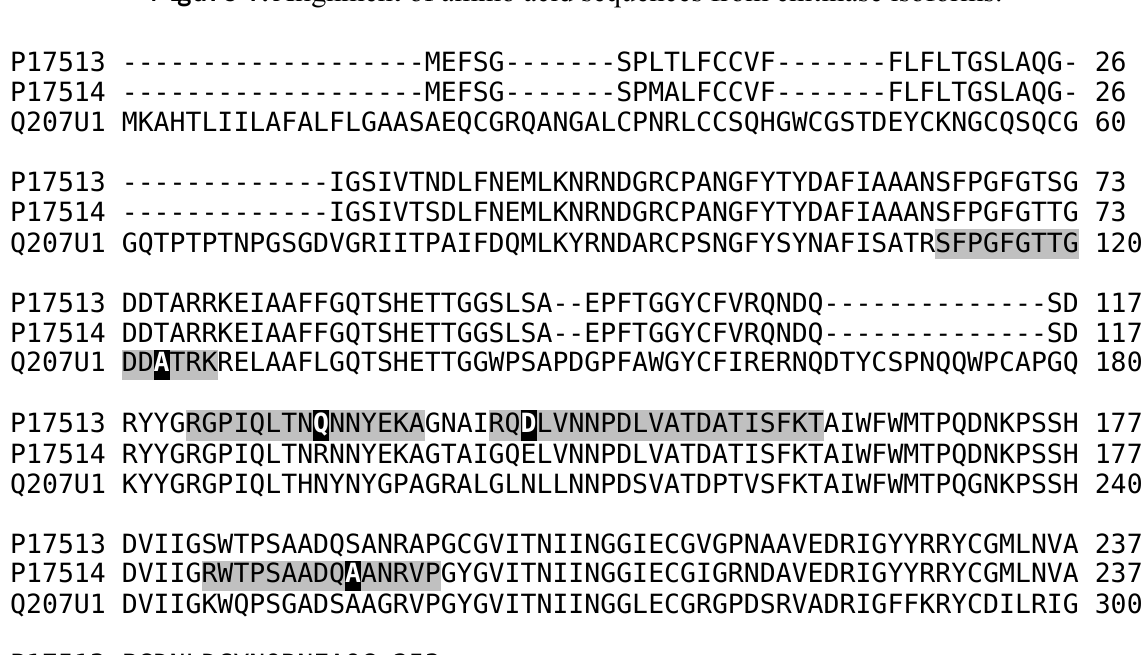
Figure 4. Alignment of amino acid sequences from chitinase